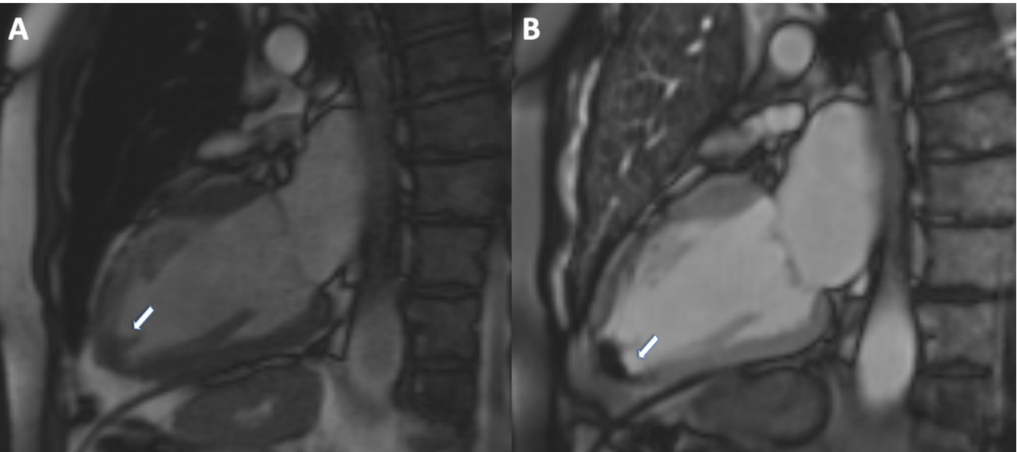
Figure 4. ( A ) 72 year old male patient with previous AMI on LAD territory. The patient was admitted to hospital due to chest pain. Images show possibility of a left ventricular thrombus on two chamber cine image (( B ), arrow). Finding was confirmed on two chamber early gadolinium enhancement (( B ),